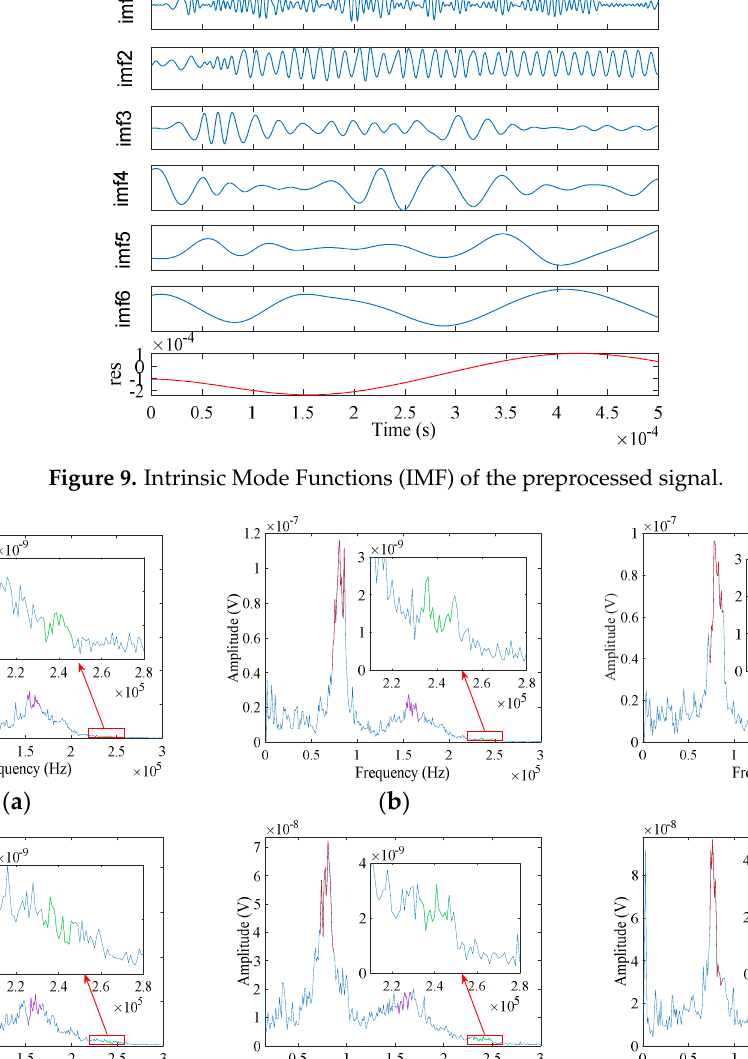
Figure 11. The changing curves of the second-order nonlinear coefficient. Figure 12. The changing curves of the third-order nonlinear coefficient. 4.4. Validation of the Nonlinear Ultrasonic Harmonic Detection Method Based on HHT